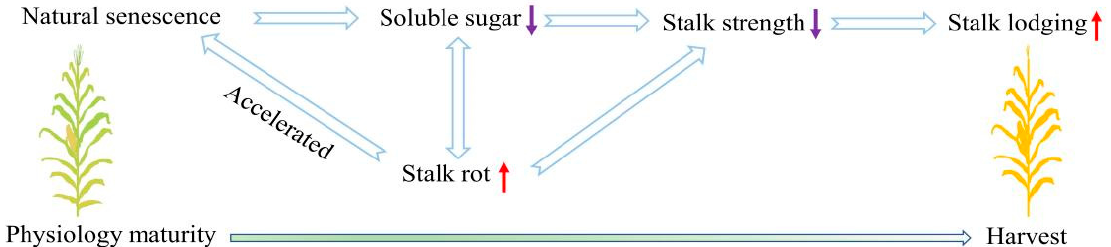
Figure 11. Effect of stalk rot on maize lodging after physiological maturity.